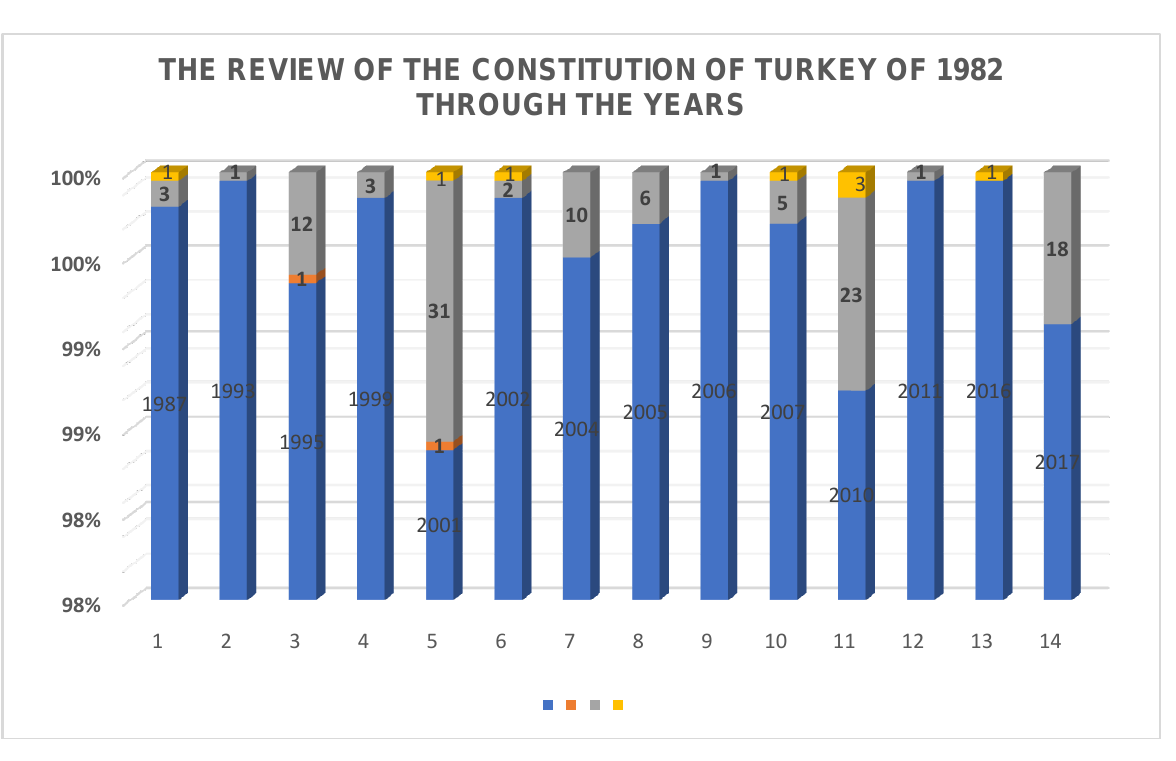
Table 1. The review of the Constitution of Turkey through the years (review and changes in its Preamble, articles, and temporary articles) (Source: own